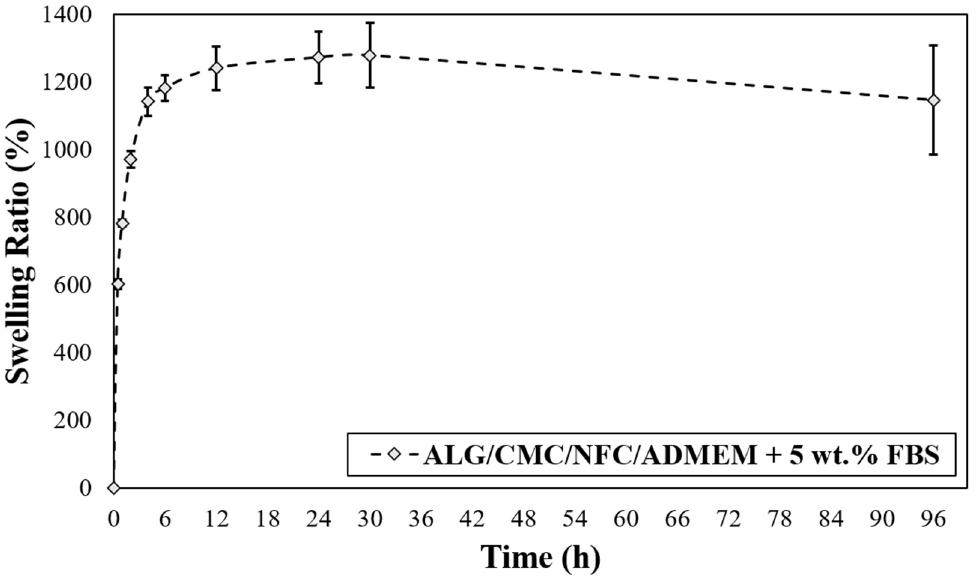
Figure 3. Scaffold swelling test for ALG/CMC/NFC-based bioink formulation.